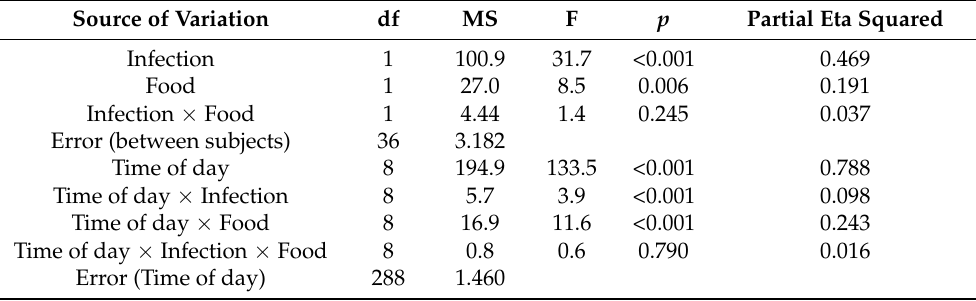
Table 2. Repeated measures analysis of variance on the effect of infection (first factor), food (second factor), and hour of the day (repeated factor) on Ceratitis capitata male sexual signaling. Times of day from 7:00 to 15:00 (the most sexually active period of the day) of adult day 5 were considered in the